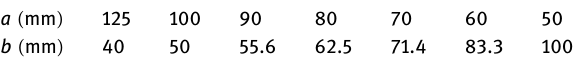
Table 3: Length changes of the two half